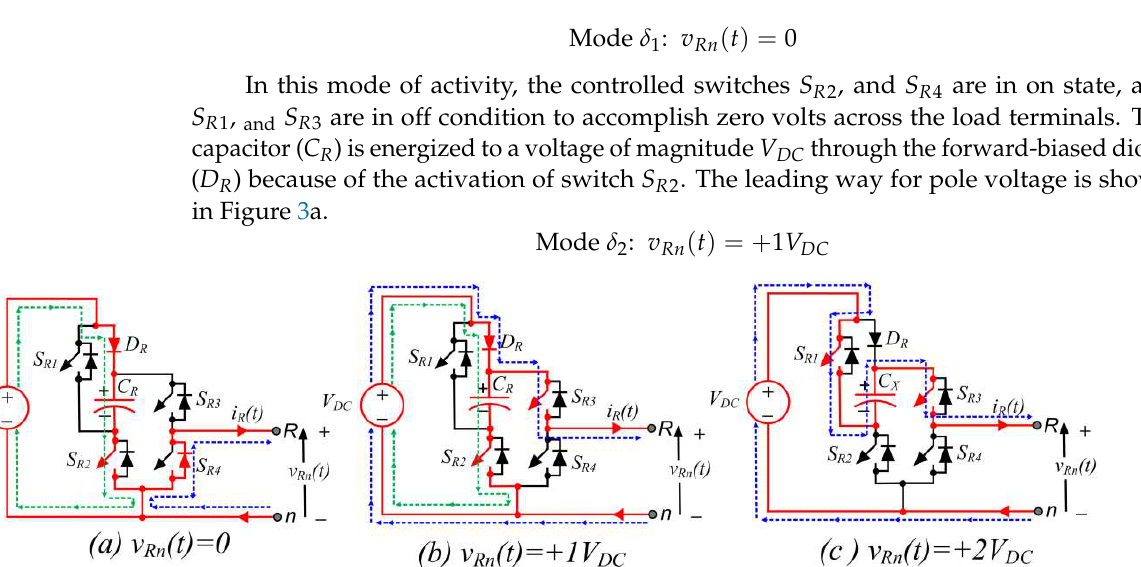
Figure 2. Circuit diagram for per phase leg R. Mode δ 1 : v Rn ( t ) = 0